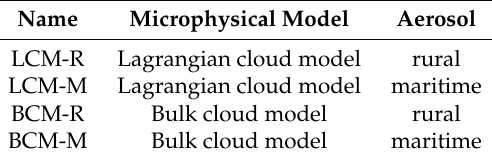
Table 2. Overview of conducted